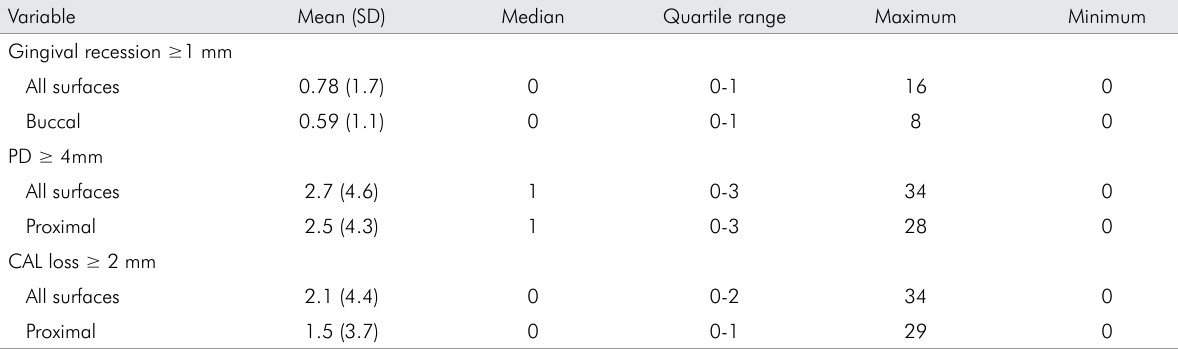
Table 3. Number of sites per person with GR ≥ 1 mm, PD ≥ 4 mm, and CAL loss ≥ 2